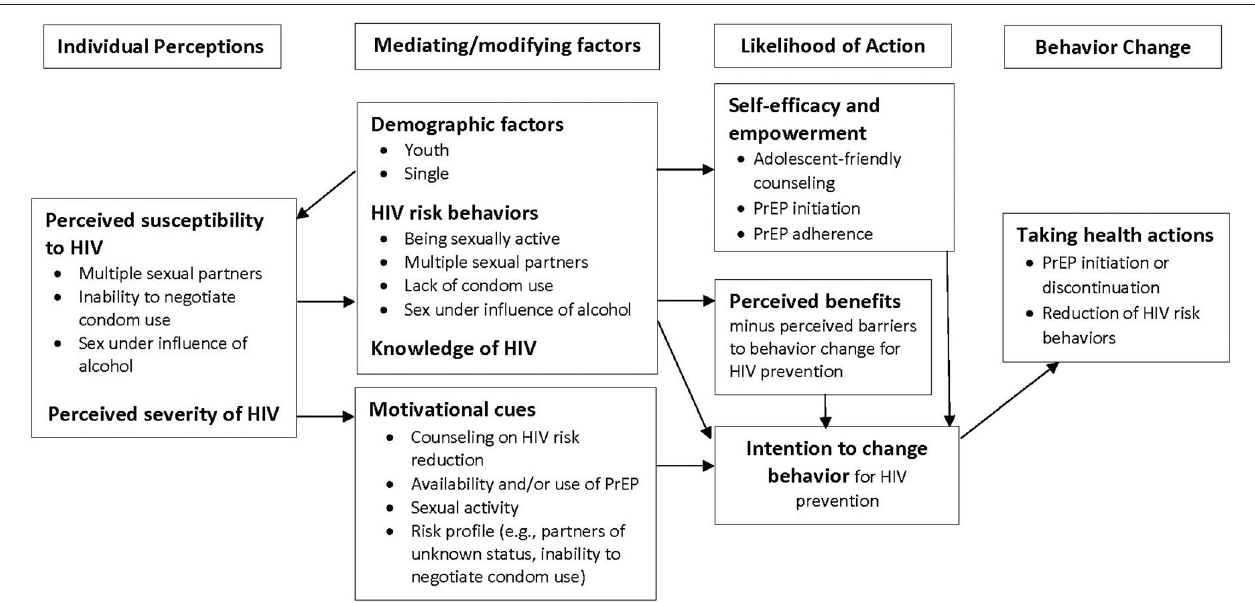
FIGURE 1 | Application of the Expanded Health Belief Model to understanding perceived HIV risk and sexual behaviors among young women enrolled in a PrEP trial in